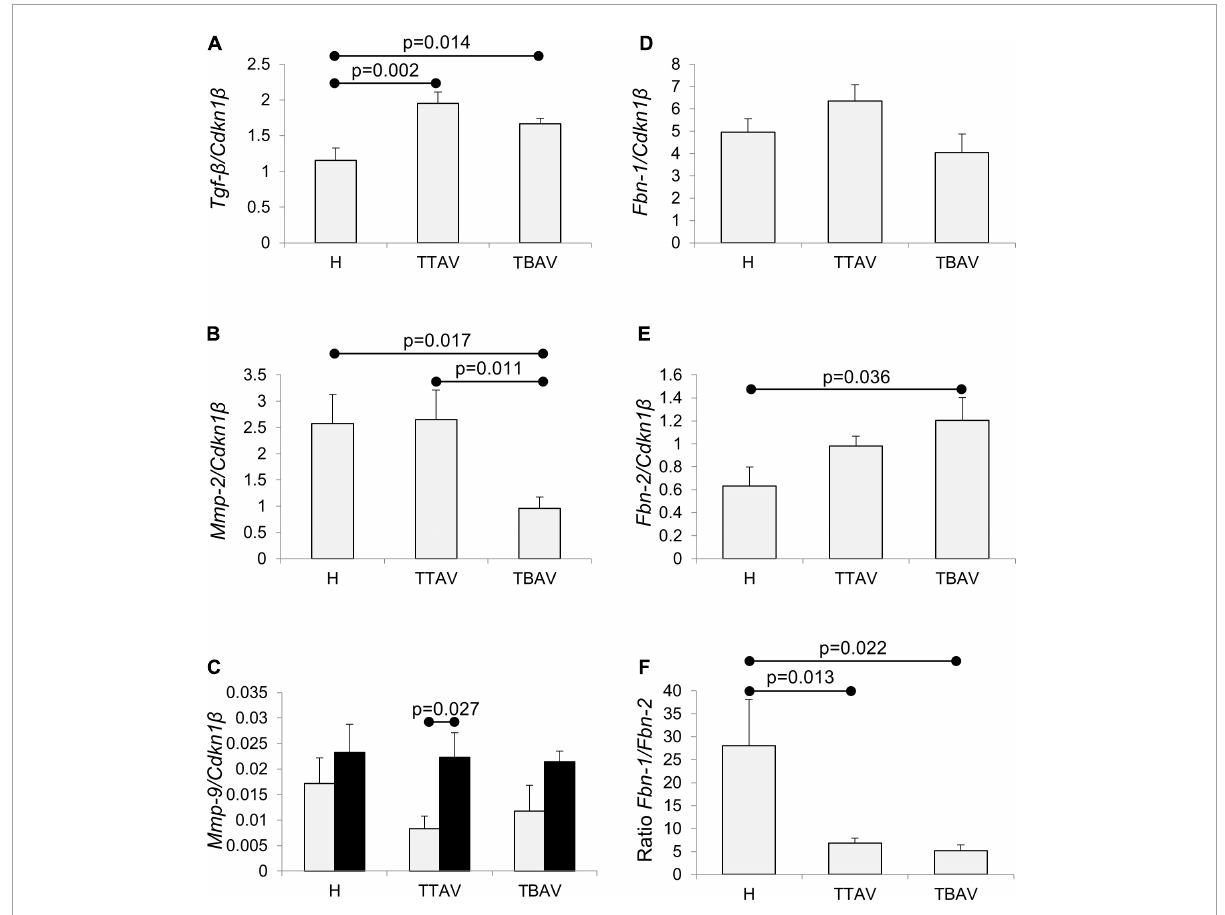
FIGURE5 Analysis of Tgf- β , Mmp-2 , Mmp-9 , Fbn-1 , and Fbn-2 mRNA expression in the ascending aorta of hamsters grouped according to the strain and the valve morphology. Tgf- β expression (A) was significantly higher in animals of the affected strain irrespective of aortic valve morphology. Mmp-2 expression (B) was significantly reduced in animals with BAV from the affected strain. Mmp-9 expression (C) increased with age, although significantly only for T-TAV animals, but did not change significantly with the strain and the valve morphology. Fbn-1 expression (D) did not significantly change in animals of the affected strain, both with TAV and BAV. Fbn-2 expression (E) was higher in animals of the affected strain, although differences were significant only for animals with BAV. Fbn-1 / Fbn-2 expression ratio (F) was over fivefold reduced in animals from the T strain, both with TAV and BAV. The expressions were normalized against the reference gene Cdkn1 β . H, control strain; TBAV, bicuspid aortic valve from the affected strain; TTAV, tricuspid aortic valve from the affected strain. Only significant p -values are